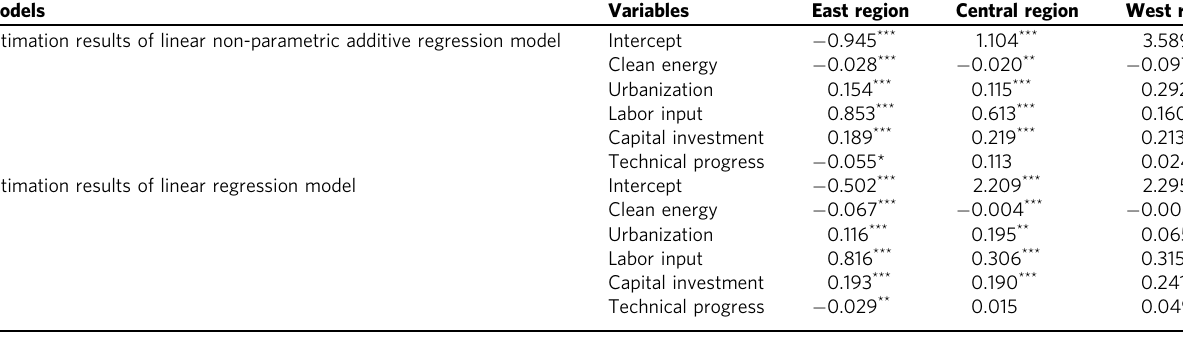
Table 5 The linear effect of CED on regional economic growth (dependent variables: GDP). Models Estimation results of linear non-parametric additive regression